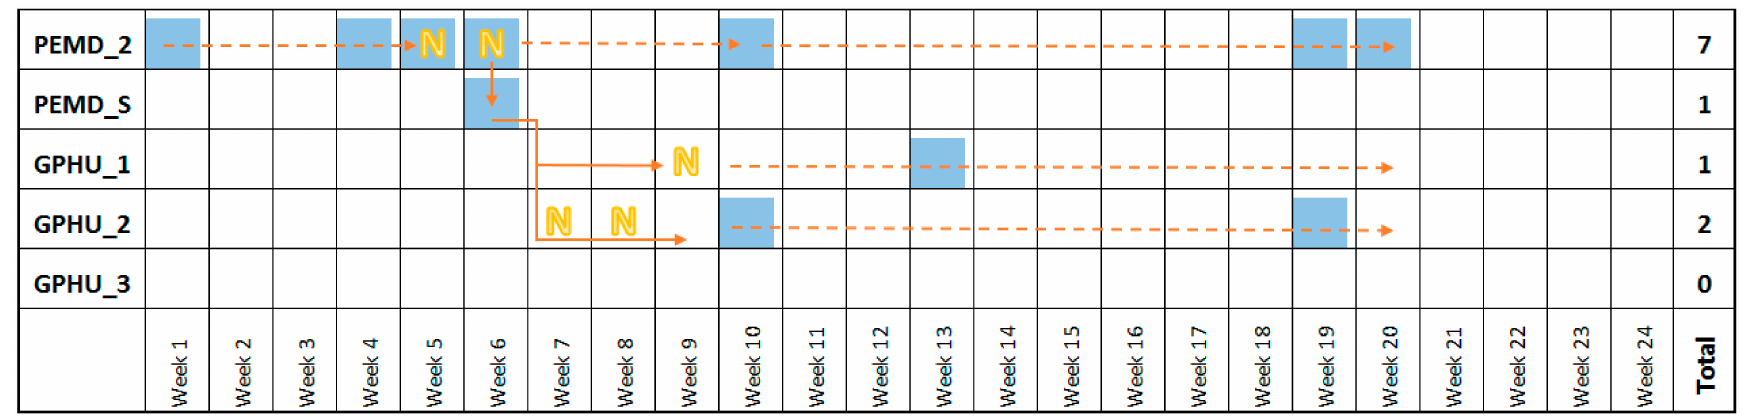
Figure 2. Transfer of contamination: the case of Paracoccus yeei . The names of the MPs are explained in the legend of Table 1. N: phone used the night by the paediatrician on